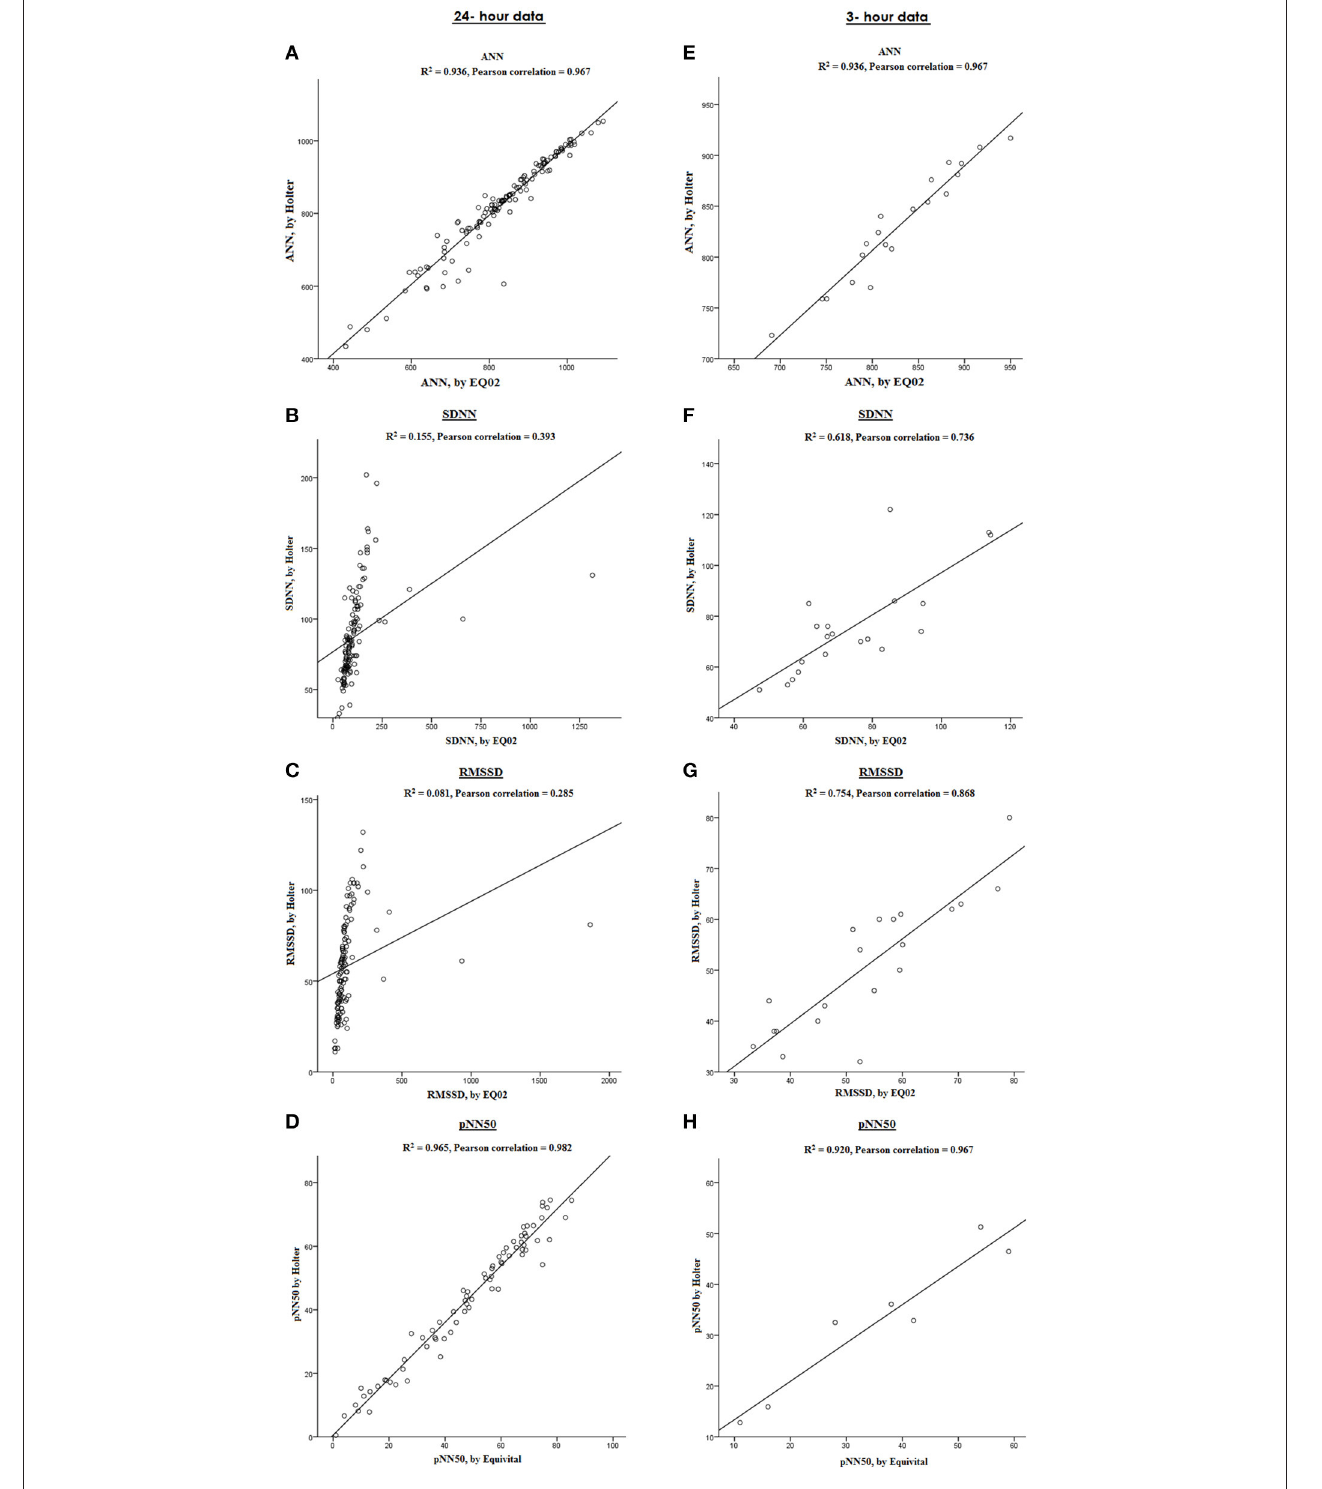
FIGURE 8 | Comparison between HRV parameters measured by EQ02 and Holter. Correlation between ANN, SDNN, RMSSD, and pNN50 in a participant from both devices over 24h (A–D) and in a sub-selection of 3-h data with artifact percentage of 1.15% (E – H) .